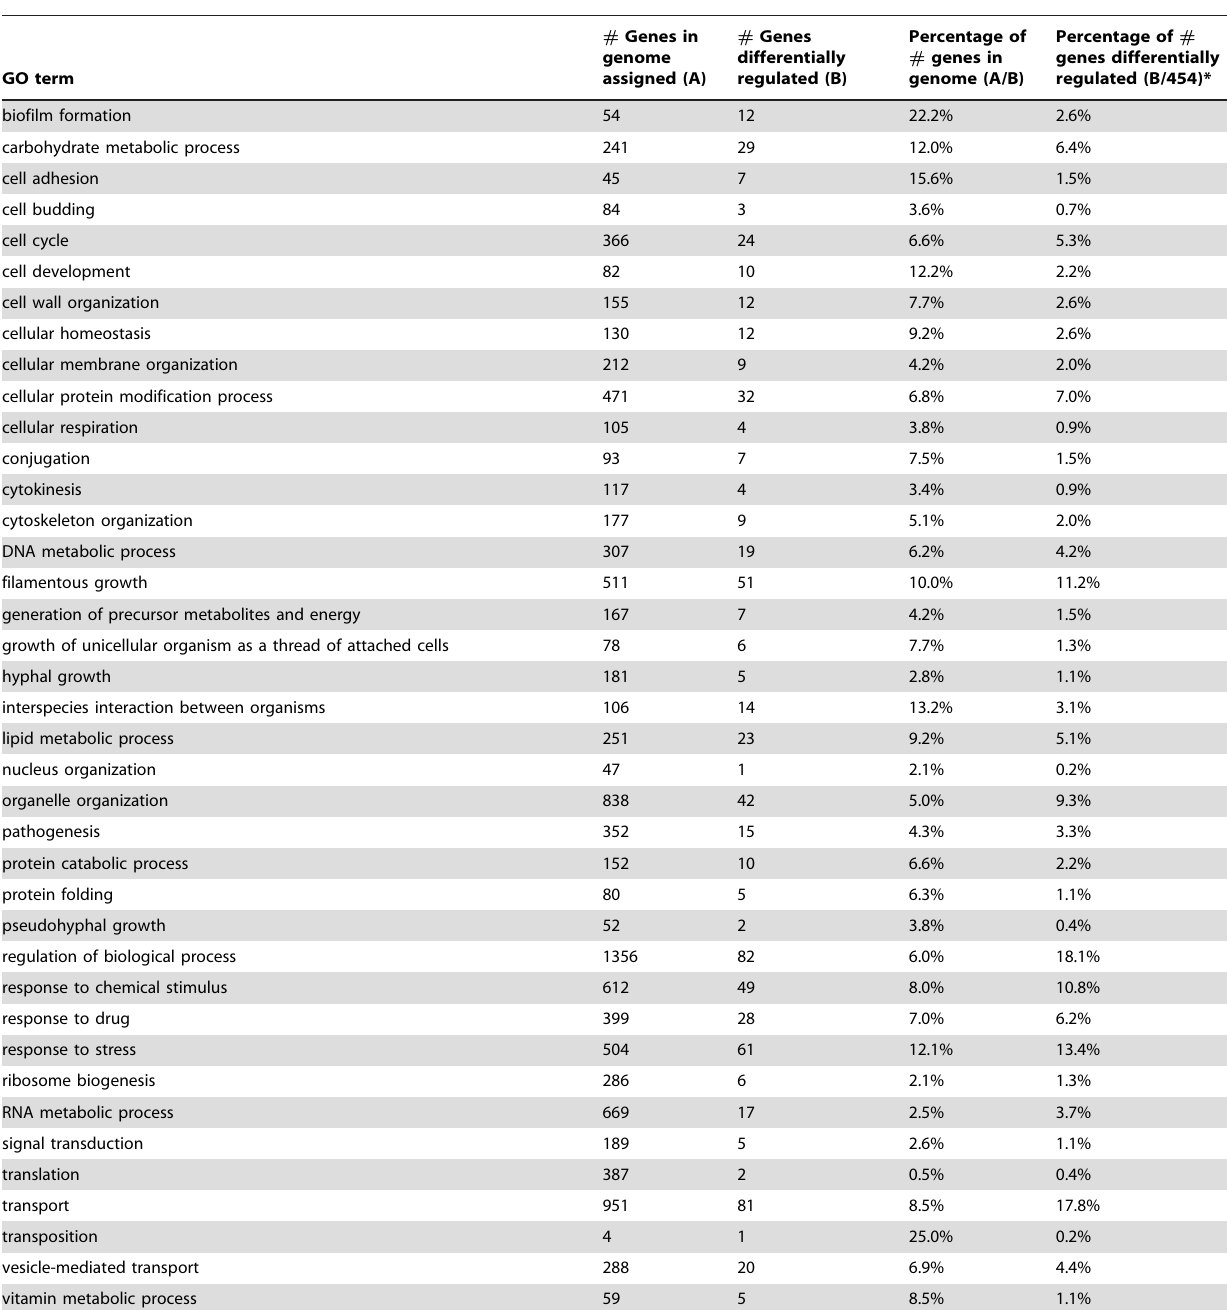
Table 3. Biological process categories of C. albicans affected by spaceflight conditions as compared to ground control, based on GO Slim Mapper